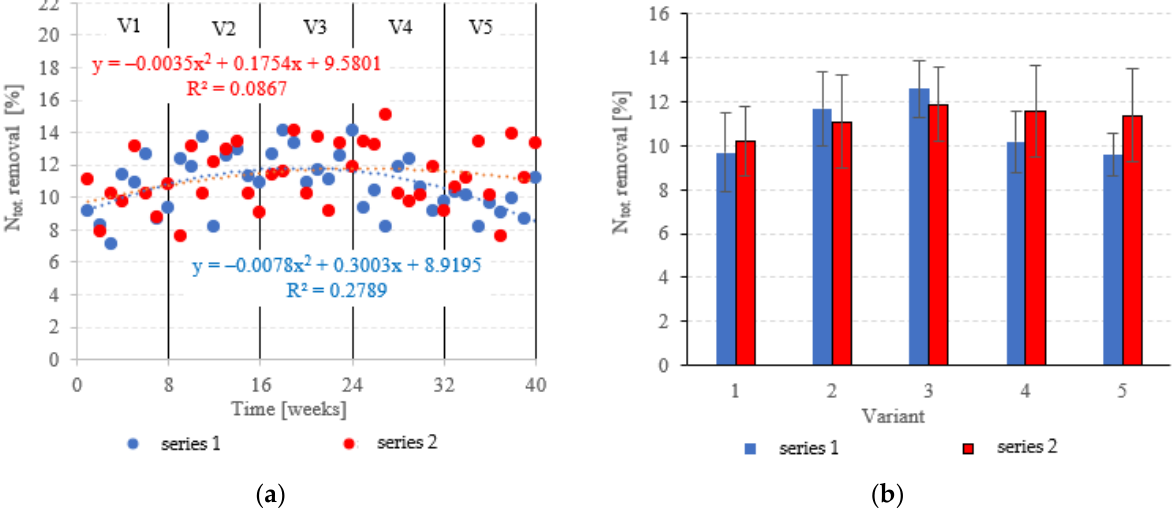
Figure 9. N tot. removal (( a ) changes throughout the experiment; ( b ) average across experimental variants).